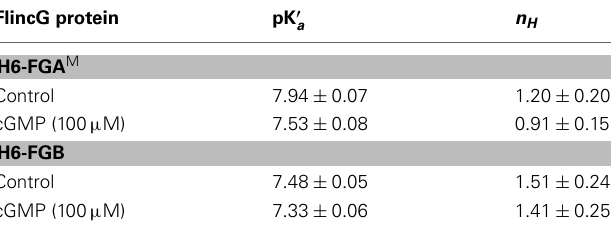
Table 4 | pH-sensitivity of purified FlincG proteins.